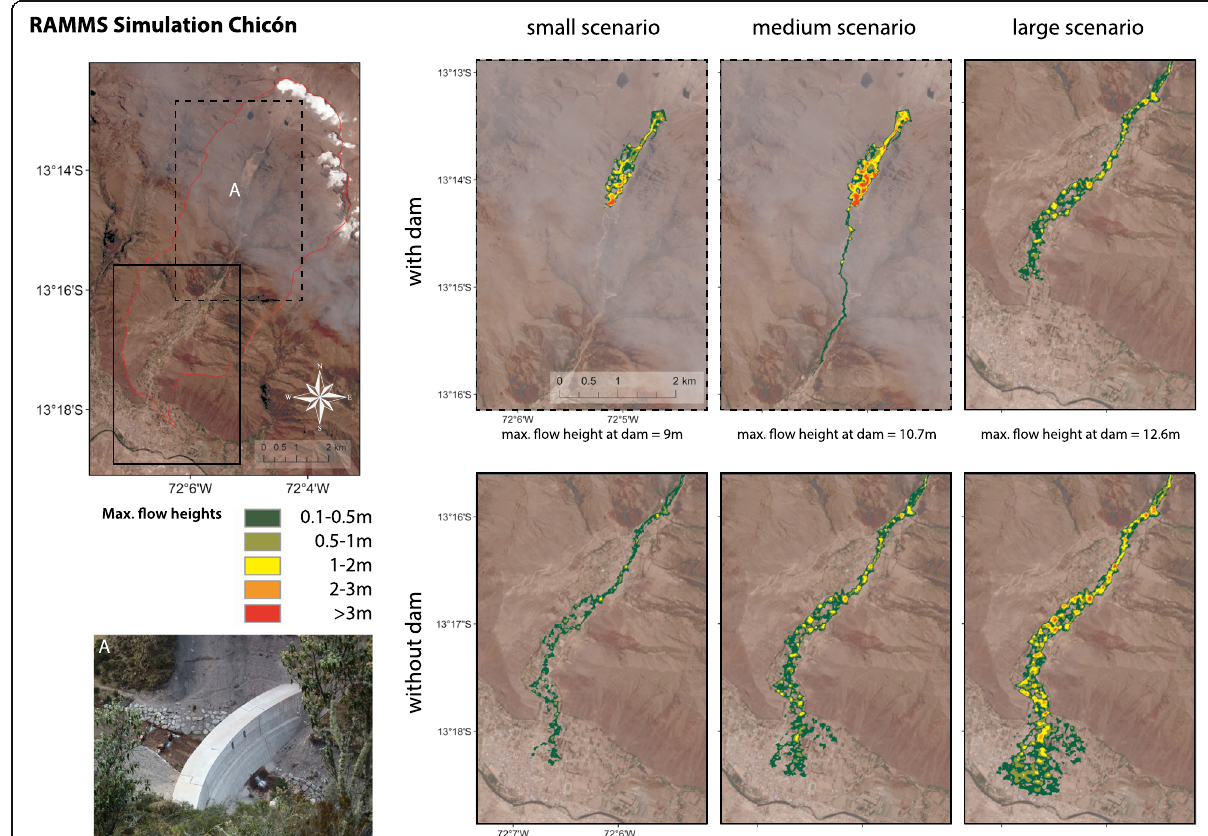
Fig. 5 Outflow paths of potential GLOFs under different scenarios (volumes) modelled with RAMMS. Upper figure: runout without any measures in place. Lower figure: considers a 10 m high dam at the outlet of Ocururuyoc